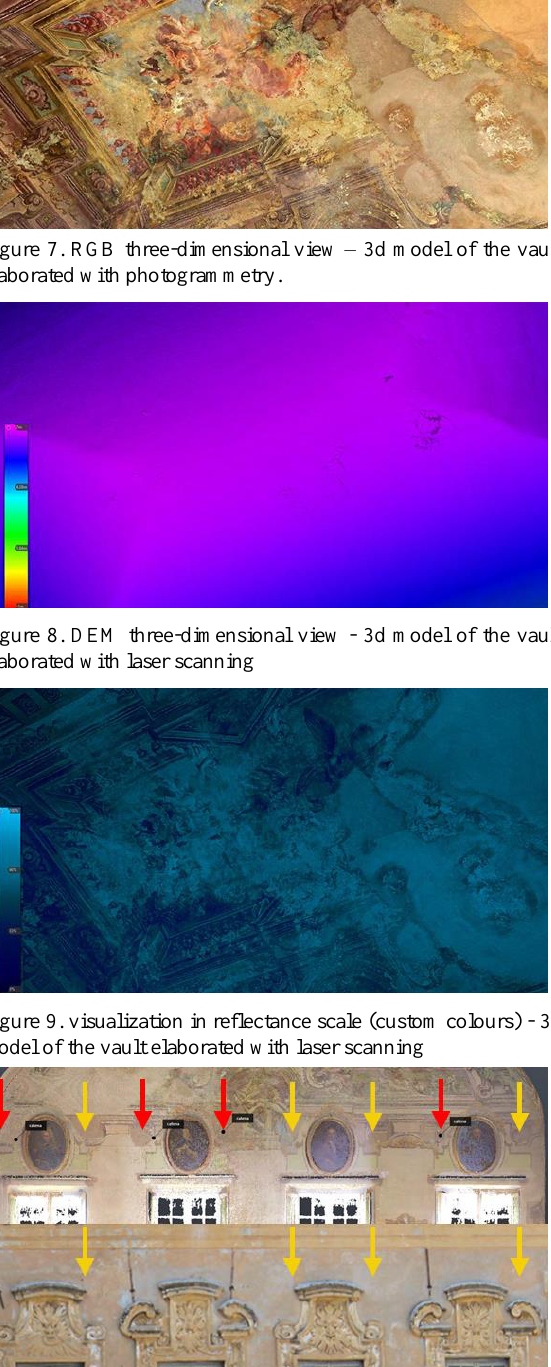
Figura 10. Interior and exterior view of the Family Portrait Room. The red arrows indicate the existing bolted end-plate; the yellow arrows indicate the plaster swellings detected where the bolted end-plate are no longer in place. The survey methodology allowed us to highlight the structural discontinuities, the plaster reconstruction areas, the zones most affected by infiltration and humidity.